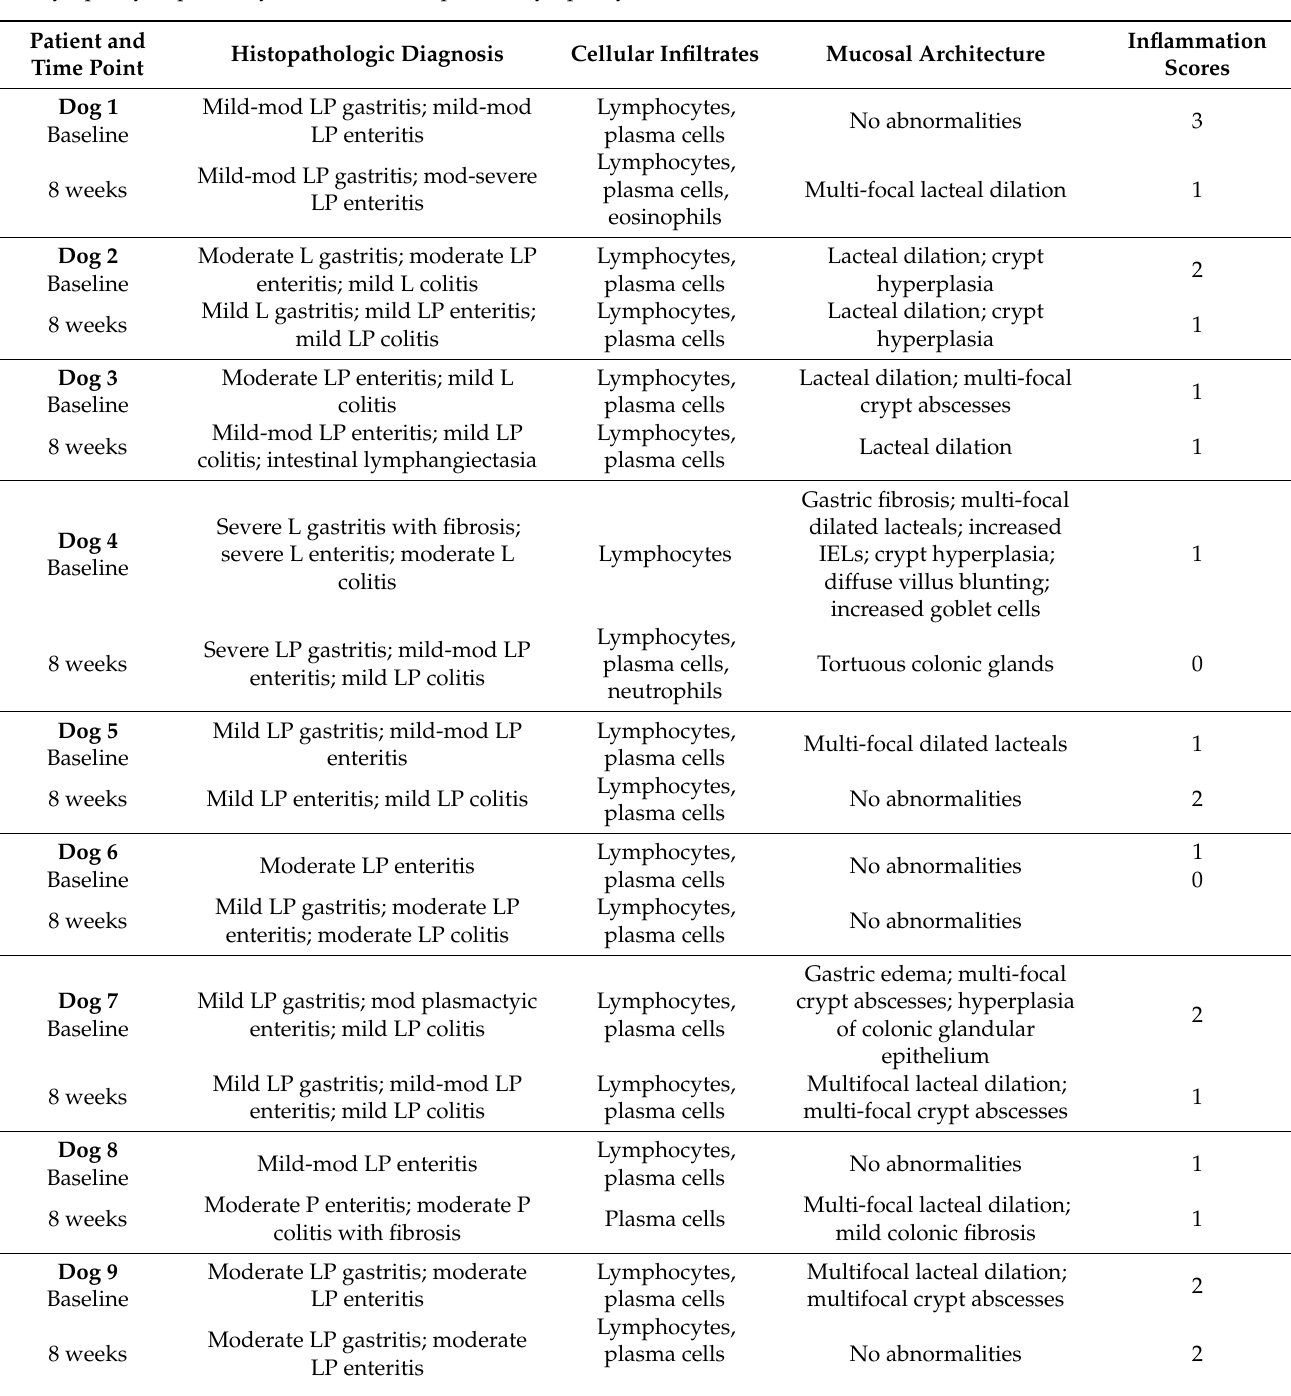
Table 1. Histopathology findings and histological inflammation scores at baseline and after 8 weeks of treatment. Biopsies were collected from the stomach, duodenum, ileum and colon. Scores range from 0 to 3, where 0 = no inflammation, 1 = mild inflammation, 2 = moderate inflammation, and 3 = severe inflammation. No significant difference was found between baseline and 8 weeks (paired t -test, p = 0.096). Mild-mod = mild-to-moderate; L = lymphocytic; P = plasmacytic; LP